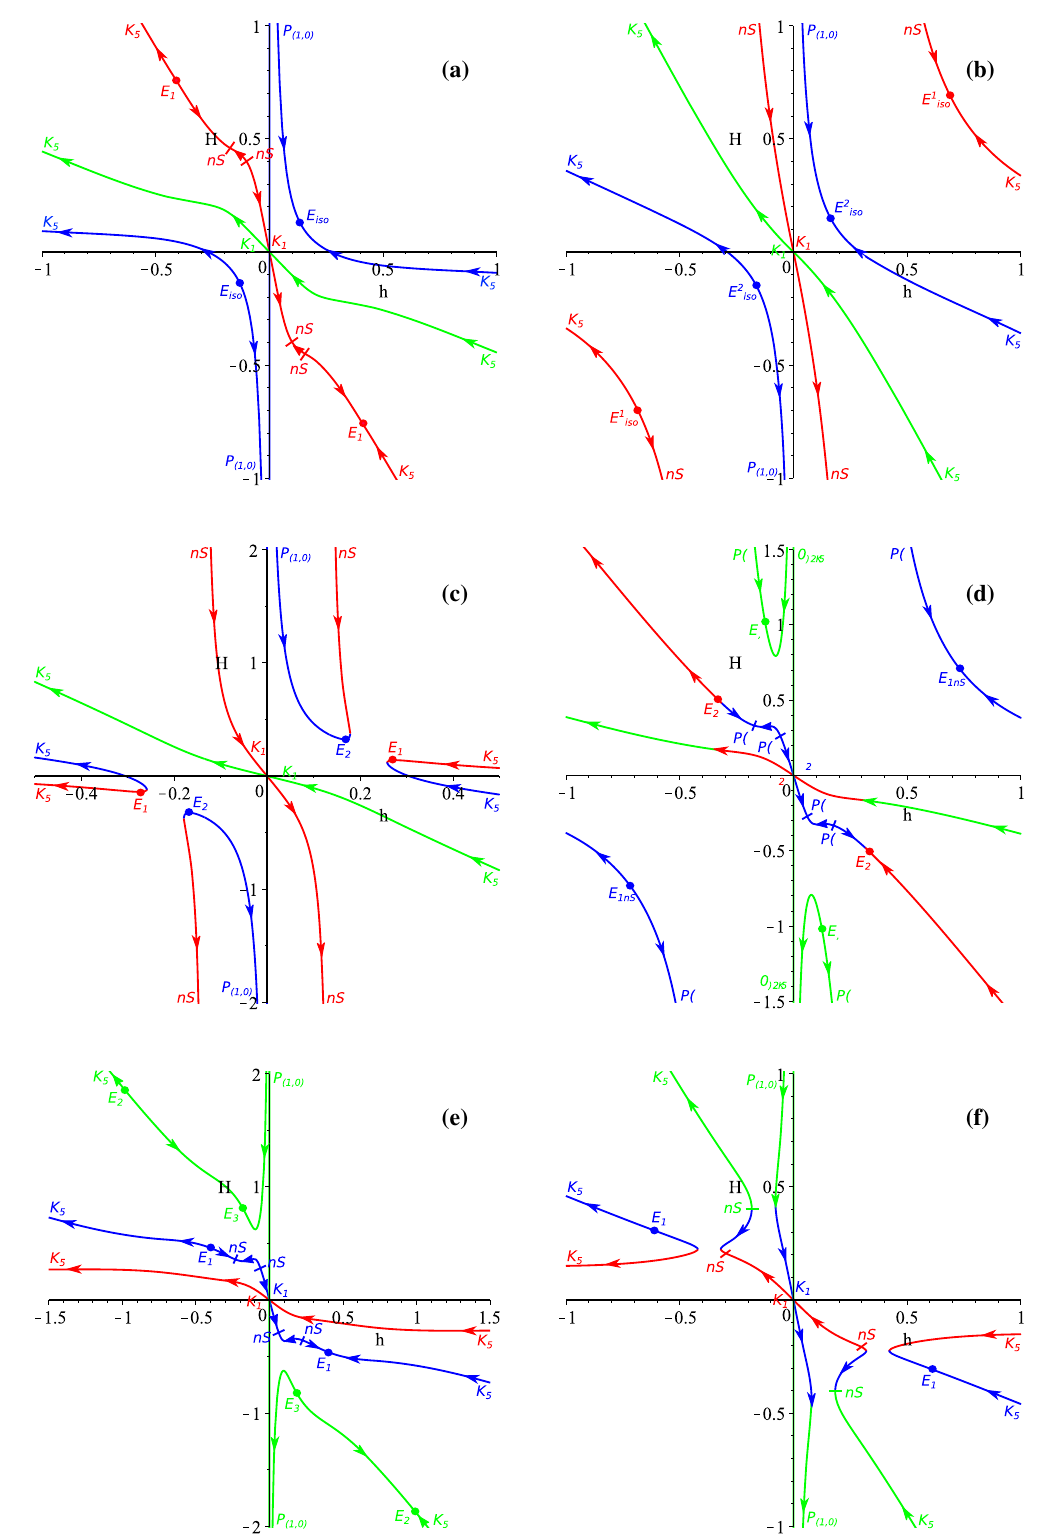
Fig. 3 Final compilations of all possible regimes in D = 6 vacuum cubic Lovelock case, on H ( h ) evolution curves; different colors corre- spond to three different branches H 1 , H 2 and H 3 ; panels layout is